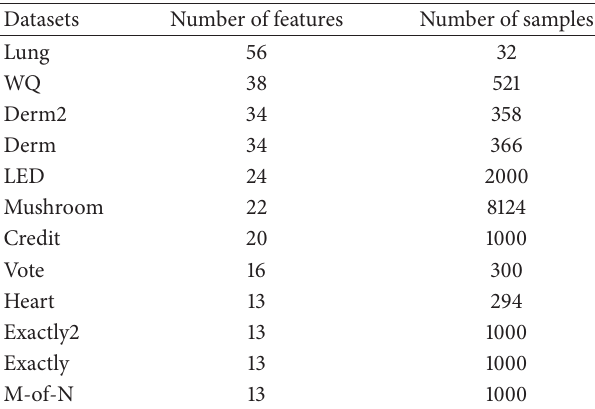
Table 1: Characteristics of datasets.